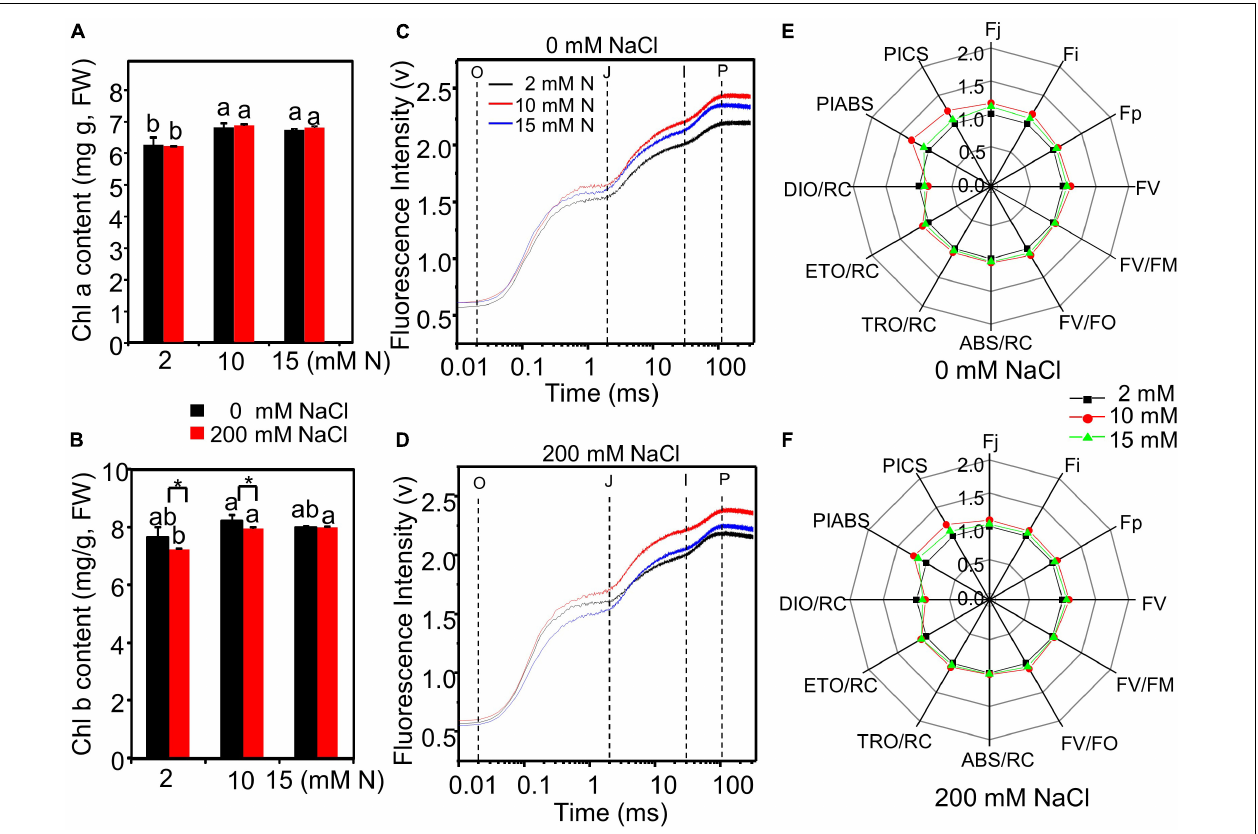
FIGURE 6 | Chlorophyll fluorescence in the leaves of bermudagrass grown with different nitrogen levels under control and salt treatment. Chlorophyll a content (A) and total chlorophyll content (B) and OJIP curve in the leaves of bermudagrass grown with different nitrogen levels (2, 10, and 15 mM) under 0 mM (C) and 200 mM NaCl (D) concentrations, respectively (O: at 0.2 ms; J: at 2 ms; I: at 30 ms; P: at maximum fluorescence position). “Radar plots” of picked parameters characterizing the influence of nitrogen concentration on PS II of bermudagrass grown under 0 mM (E) and 200 mM NaCl (F) , respectively. The parameters of plants grown under 2 mM N were set as control. Control = 1. ∗ Shows significant differences ( P < 0.05) under 200 mM NaCl treatment and 0 mM NaCl condition with the same N level by Tukey’s